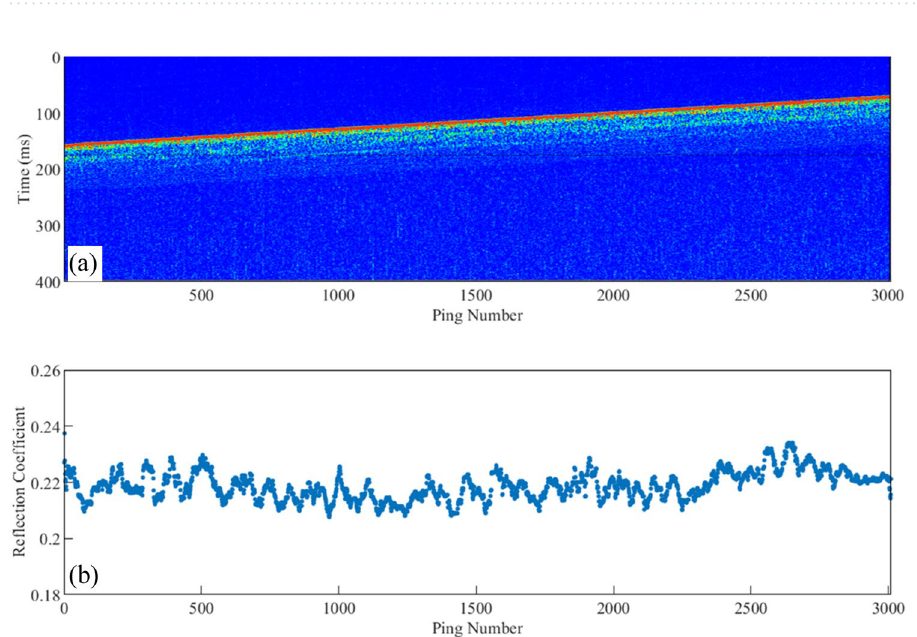
Figure 5. An example subbottom profile and the calculated seafloor reflection coefficient: ( a ) a subbottom profile; ( b ) the calculated seafloor reflection